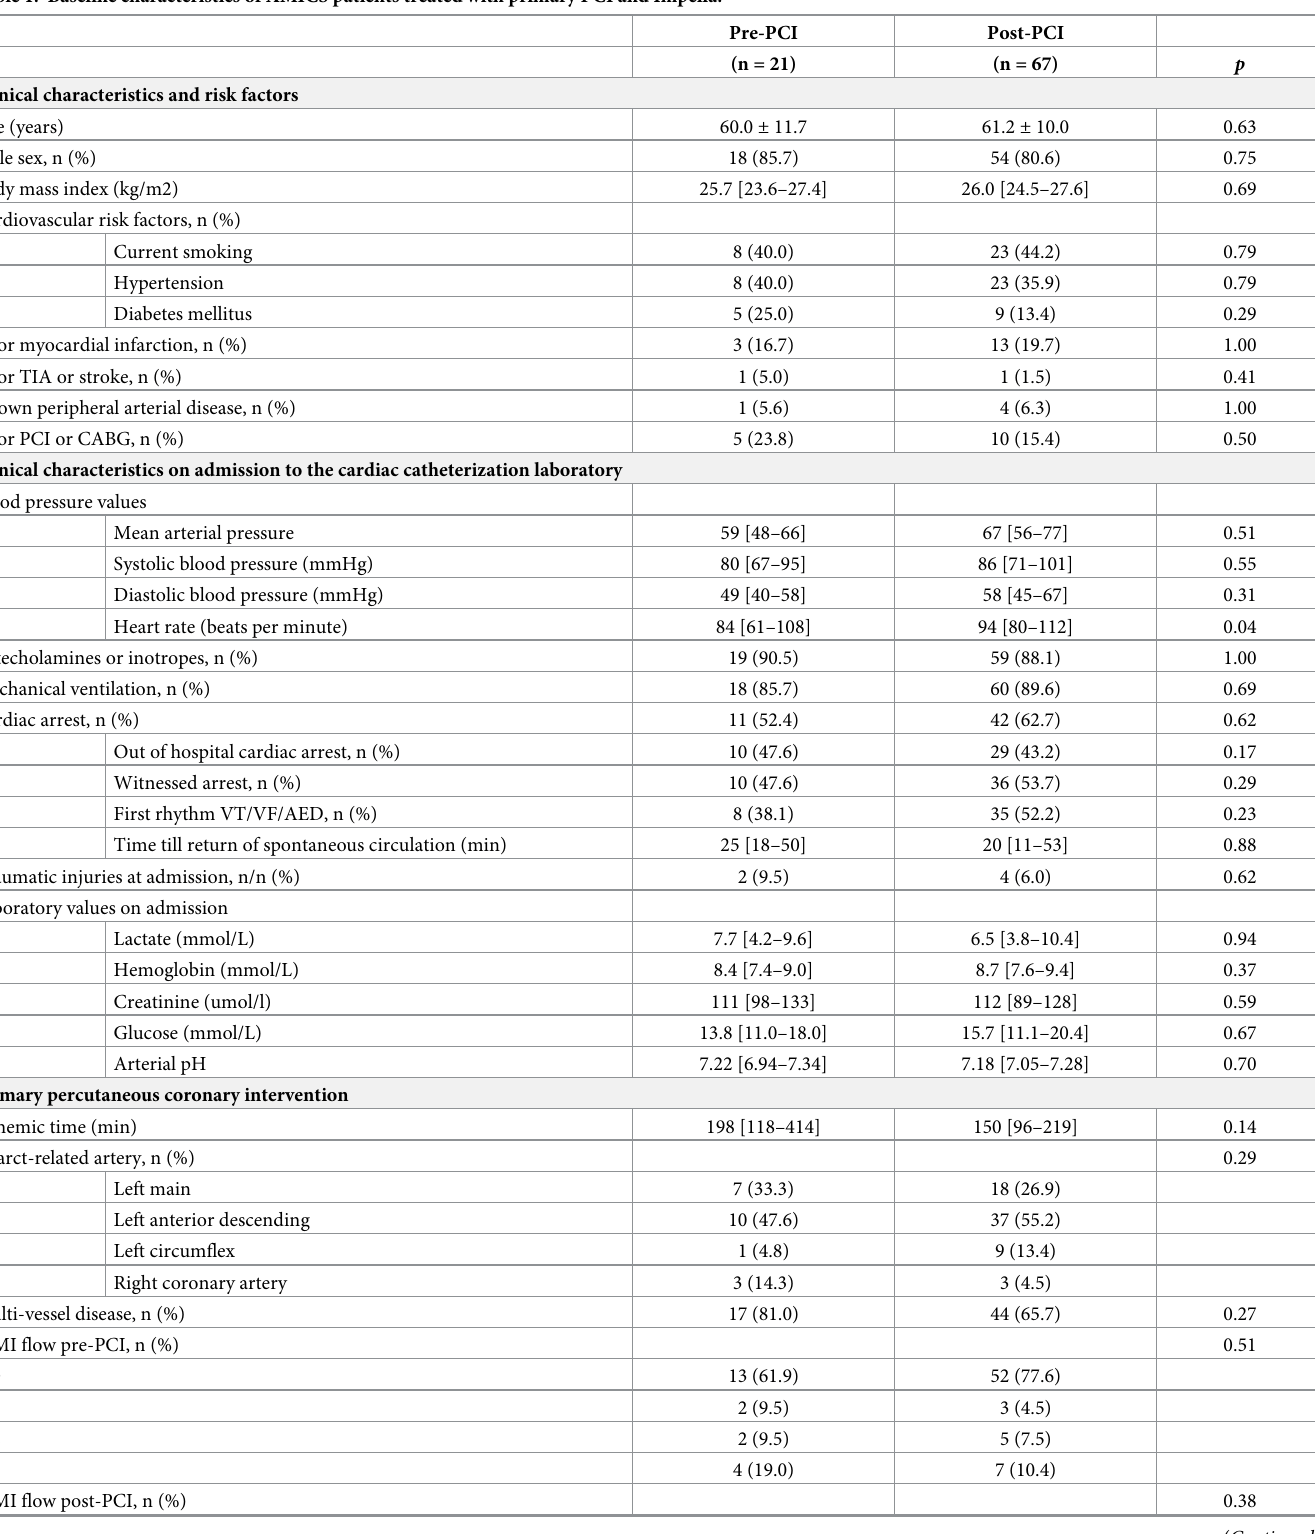
Table 1. Baseline characteristics of AMICS patients treated with primary PCI and